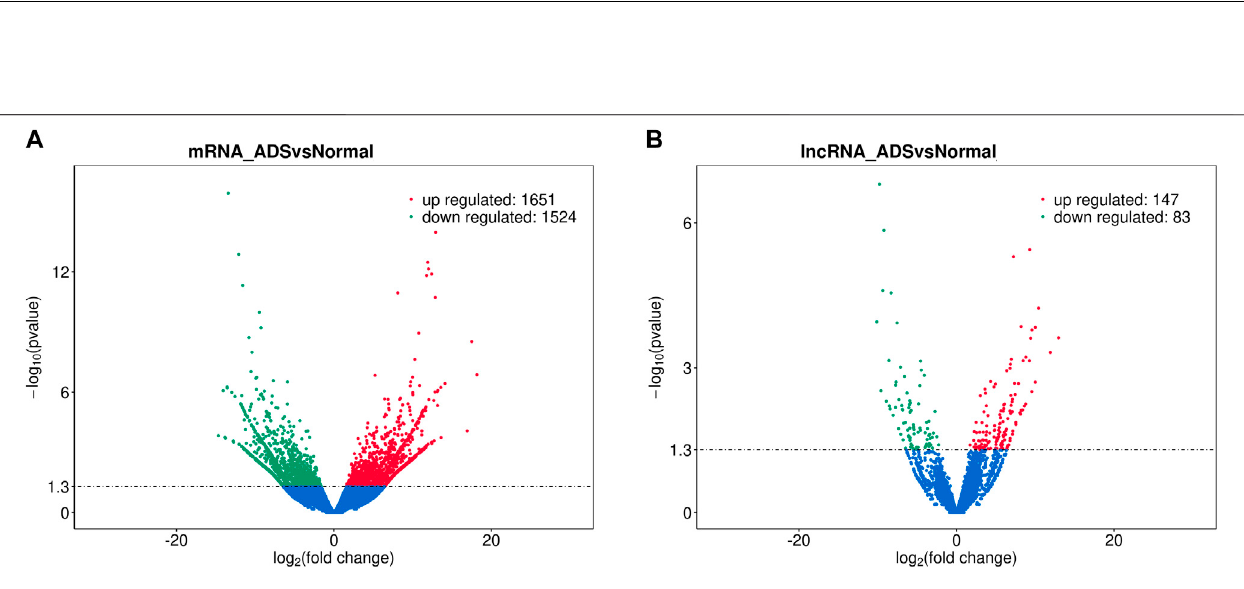
FIGURE3| Analysisofdifferentially expressed mRNAsand lncRNAs.Volcanoplotshowingdifferentially expressed (A) mRNAsand (B) lncRNAinADSandnormal groups.